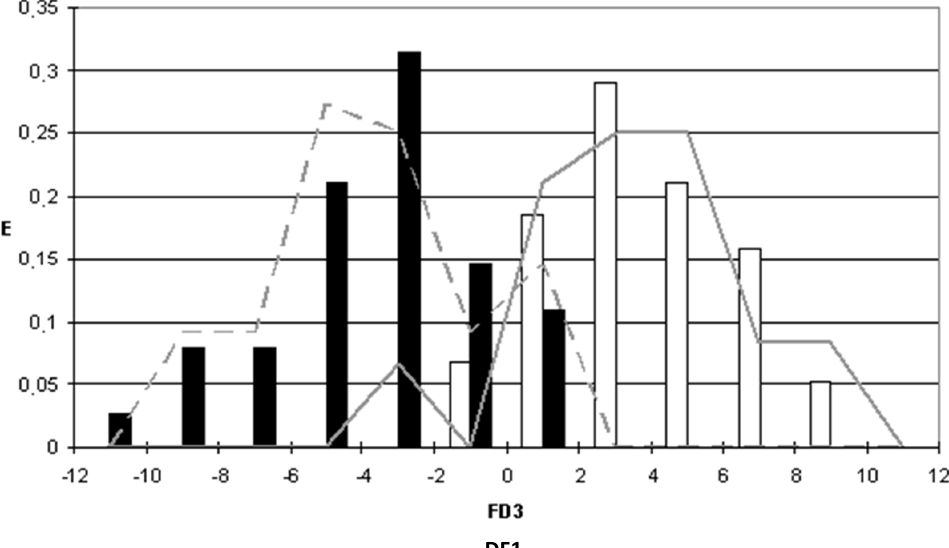
Figure 1. DF1 pharmacological distribution diagram. Black bars: Training Inactives. White bars: Training Actives. Dashed line: Test Inactives. Straight line: Test Actives.